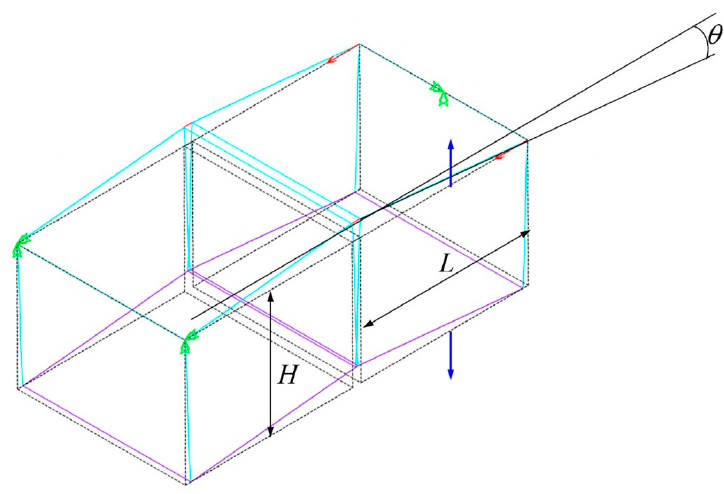
Figure 5. A schematic demonstration of the Hydrostatic Buckling and the principle of virtual work, for two connected cages. The dashed lines show the initial position of the cages while the colored solid lines present the displaced position due to Hydrostatic Buckling.